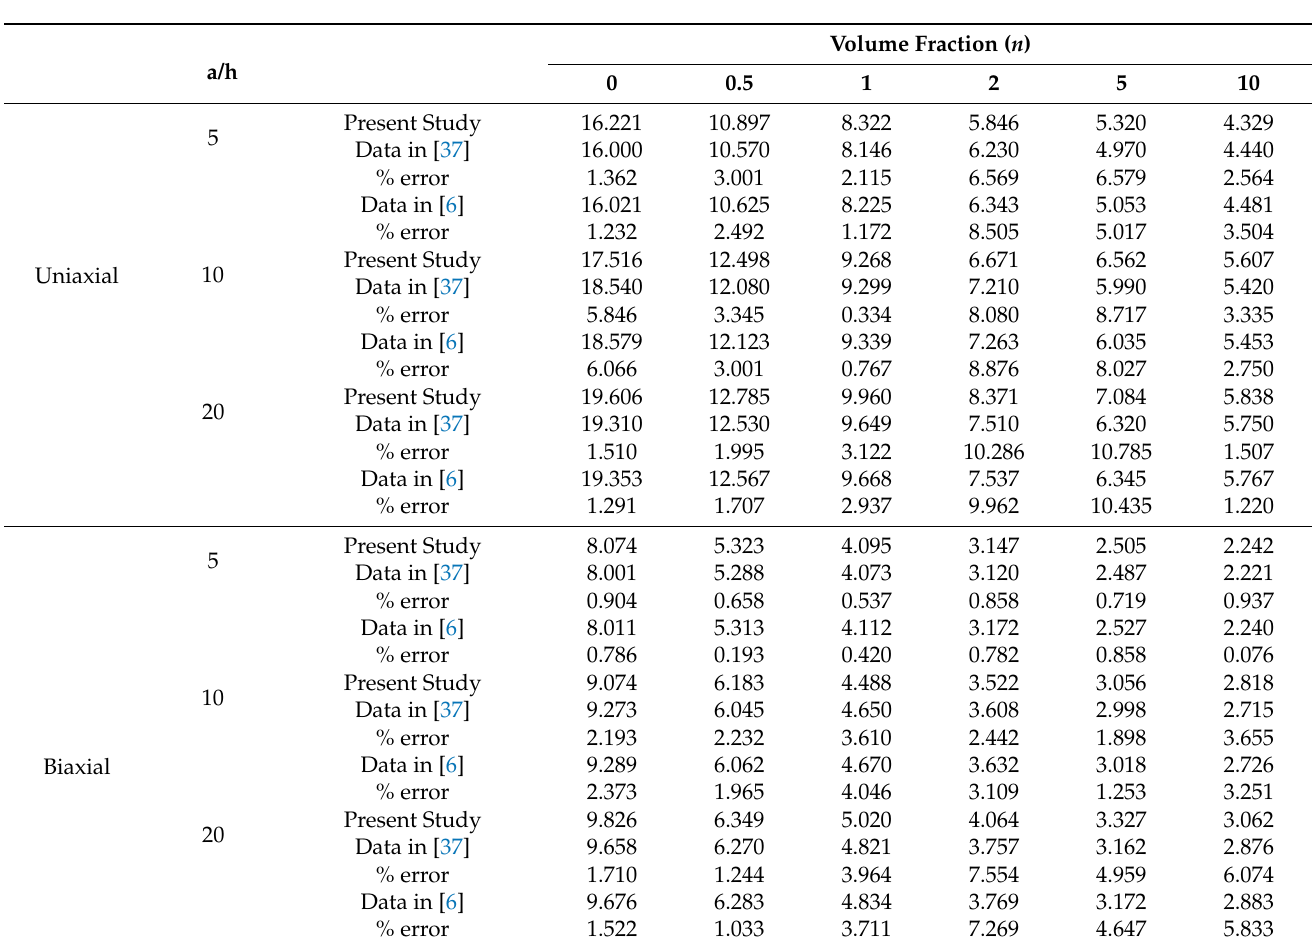
Table 3. Comparison study for the Al/Al 2 O 3